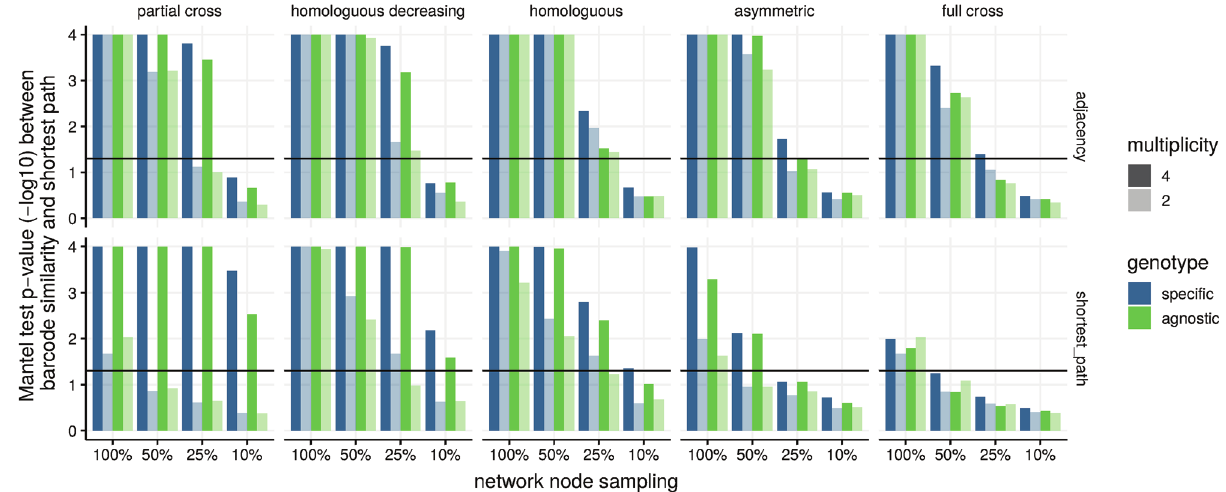
Fig 3. Correlations between a matrix based on infection barcodes similarity and the network’s adjacency (top) or shortest path (bottom) matrices. For simulated epidemics on clustered networks with 2 or 4 circulating genotypes and a variety of cross-immunity settings, we tested for correlations using p-values of two-sided Mantel tests with 10 4 permutations. For each setting, we re-sampled 20 times randomly 100, 50, 25, or 10% of the infected nodes and report the average p-value.